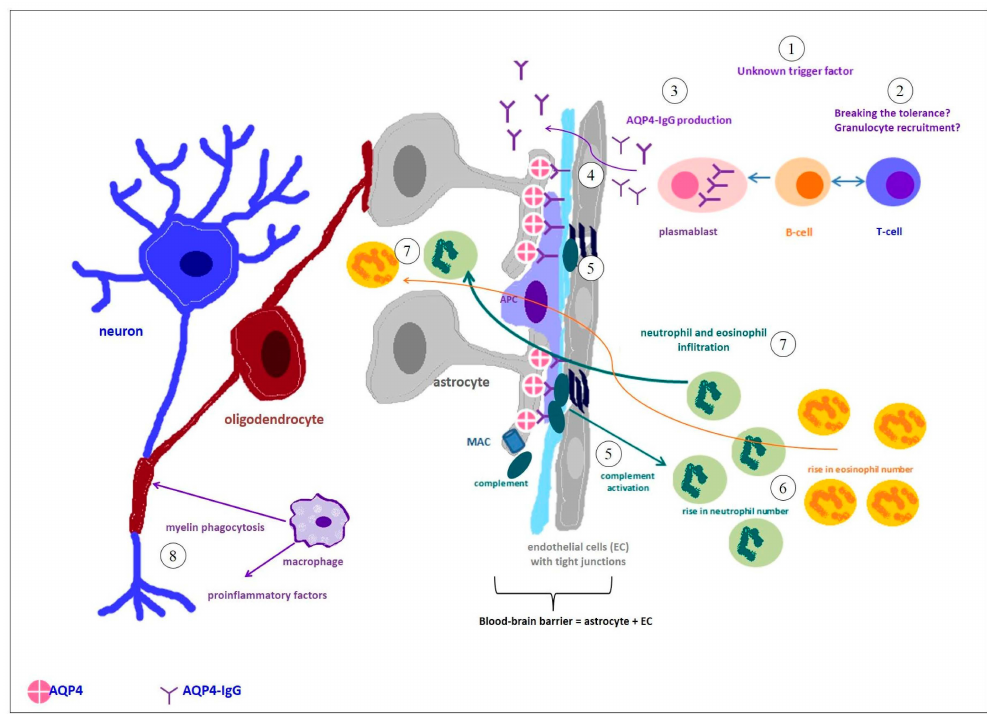
Figure 3. Immunopathogenesis of neuromyelitis optica: ( 1 ) primary immunizing event of unknown provenance; ( 2 ) T lymphocytes take part in breaking the tolerance and in recruitment of other leukocytes; ( 3 ) plasmablasts produce AQP4-IgGs, which enter the central nervous system (CNS) through ( 4 ) endothelial transcytosis or at areas of increased blood-brain barrier permeability and then bind selectively to aquaporin-4 (AQP4); ( 5 ) complement activation, leading to complement-dependent cytotoxicity and subsequent astrocyte death; ( 6 ) neutrophil and eosinophil rise in the periphery and their subsequent CNS infiltration ( 7 ) neutrophil and eosinophil infiltration ( 8 ) secondary demyelination caused by, among others, myelin phagocytosis, and bystander injury by pro-inflammatory factors. APC: antigen presenting cell; MAC: the membrane attack